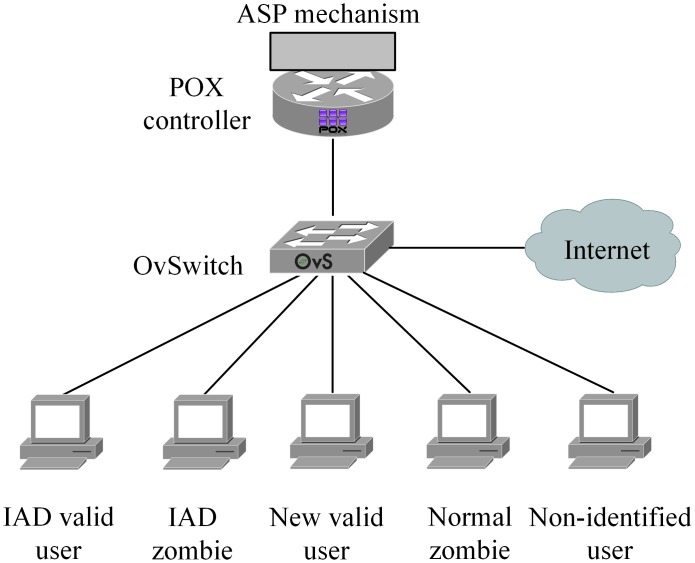
Emulation topology.